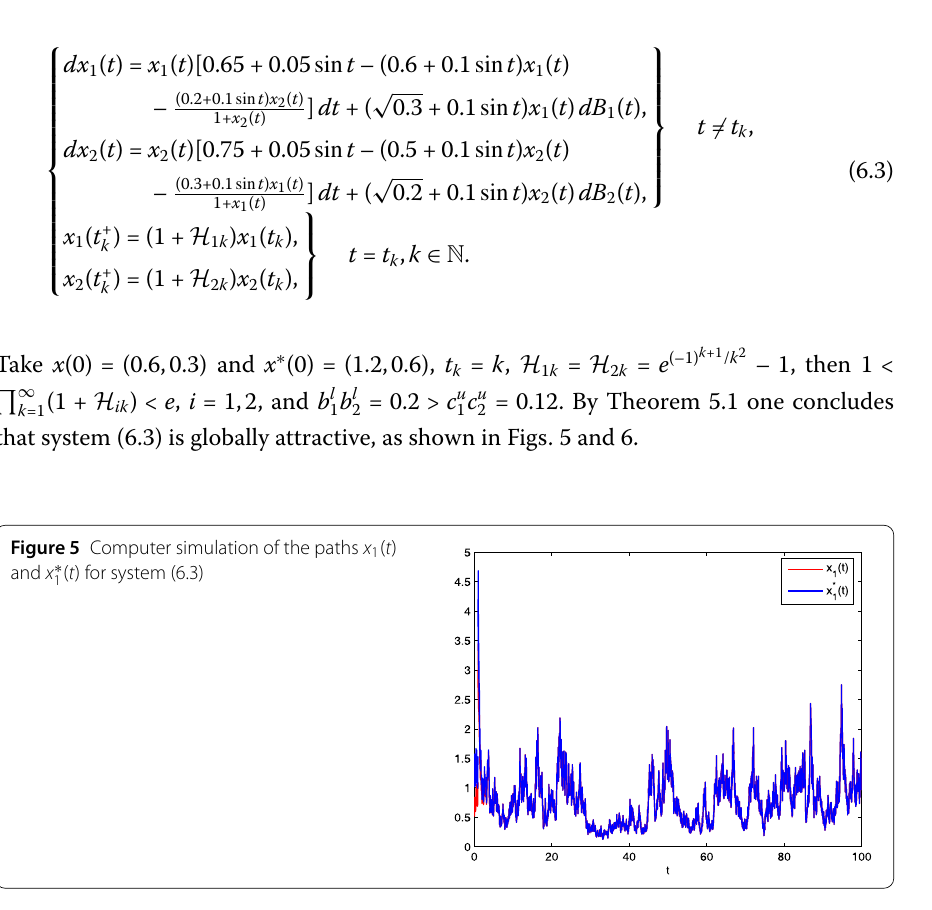
Figure 6 Computer simulation of the paths x 2 ( t ) and x